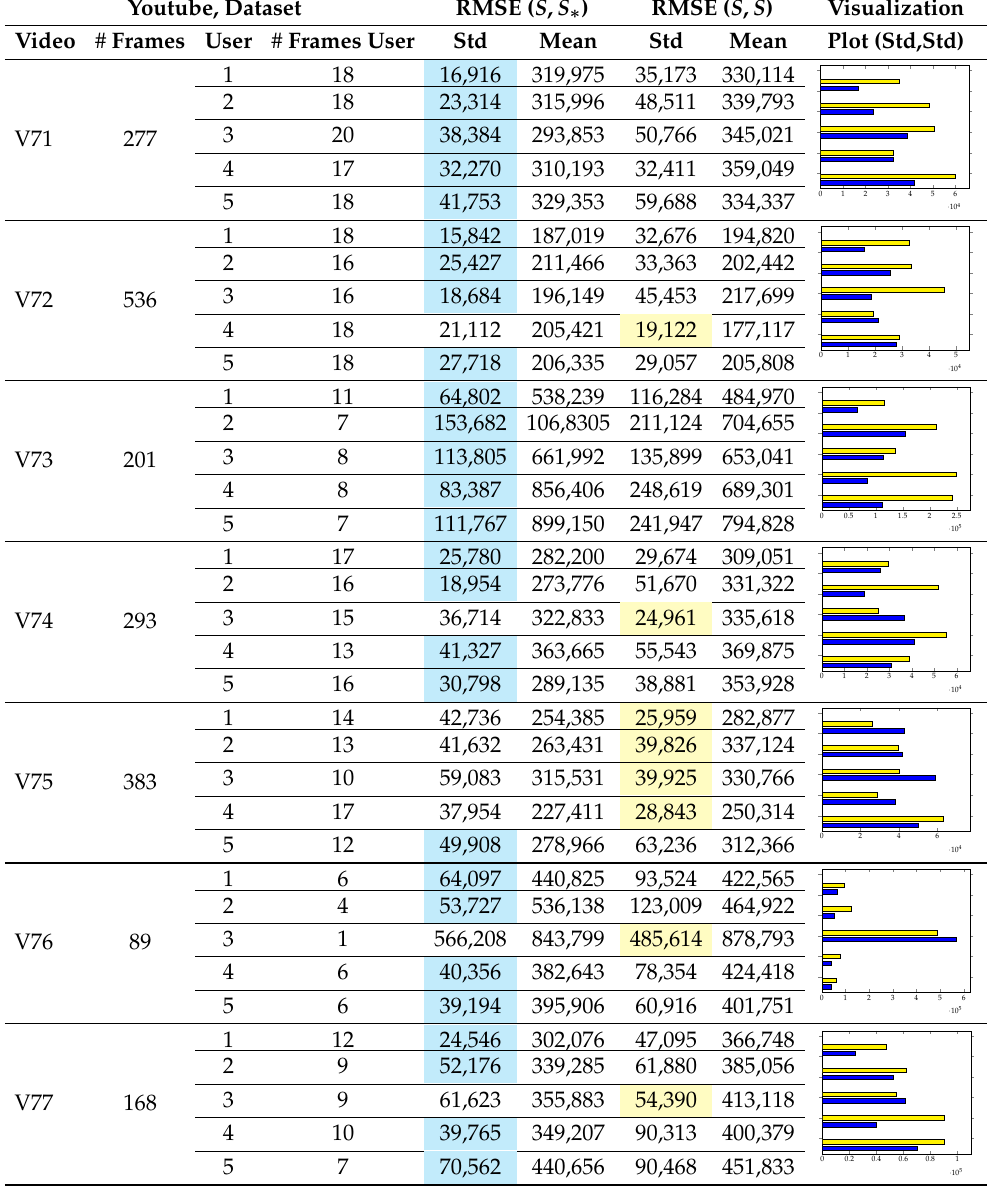
to the lowest standard deviation.